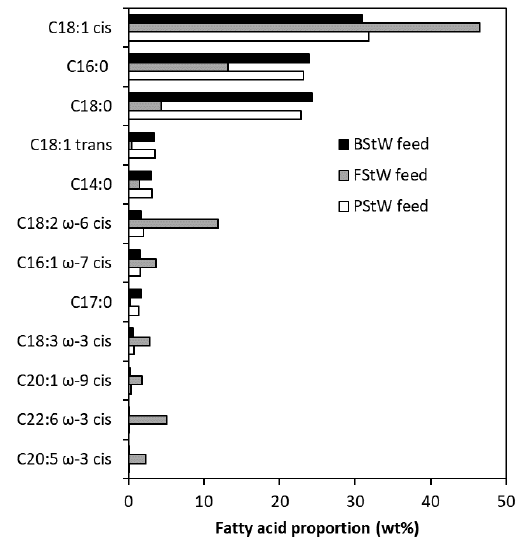
Figure 1. Fatty acid methyl ester (FAME) analysis result showing the weight proportion of the key fatty acid groups present in the fats from the MD stick water feed samples shown in Table 2 (PStW, FStW and BStW2). The full set of FAME analysis results are presented in Figure S1 of the Supplementary Material. Table 2. Summary of fatty acids detected by FAME and reported presence in animal fats. Structure and reported presence details from literature [34].